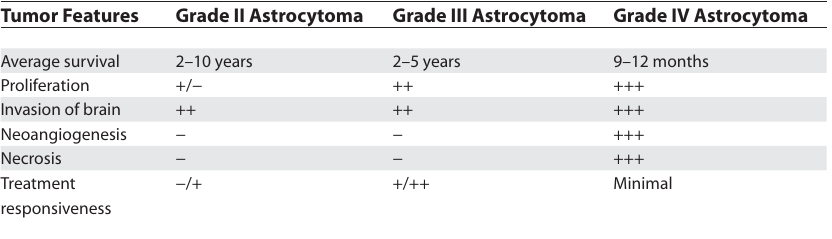
Table 1. Histological Features and Prognosis in Patients with